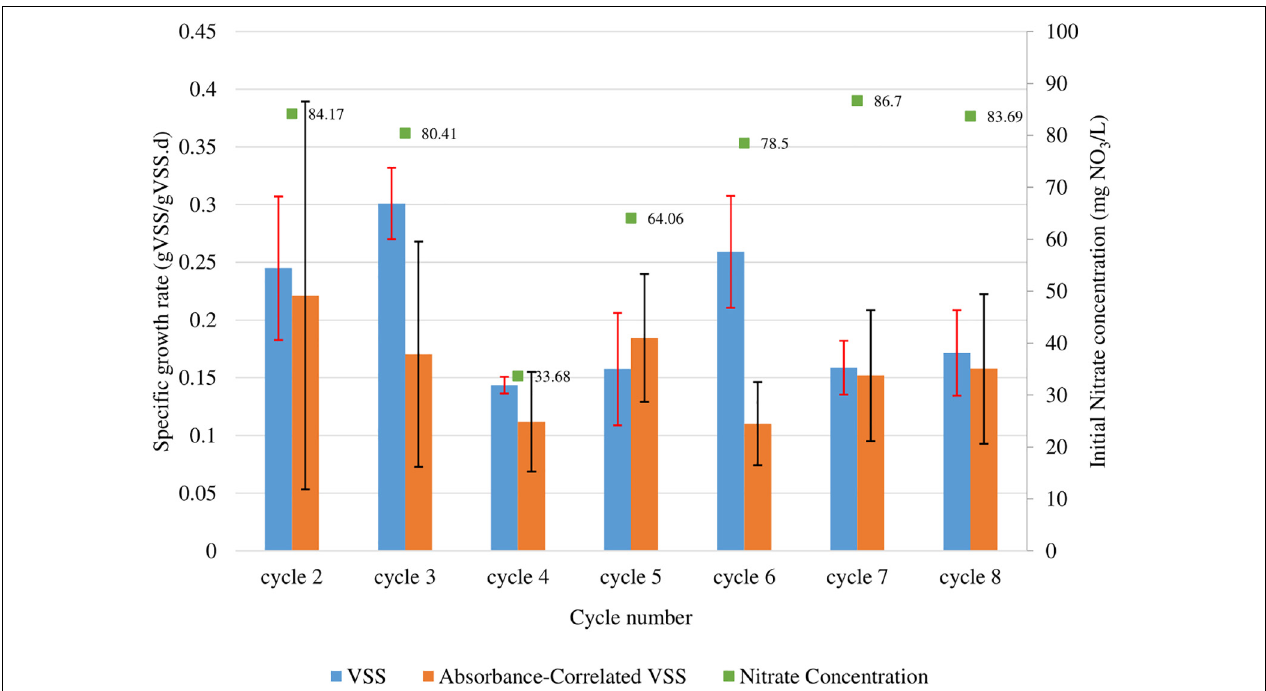
FIGURE 2 | Observed maximum growth rates of N. gaditana calculated from fitted growth curves for each batch cycle run. These growth rates were calculated from the change of mass (gVSS/L) (blue) , as well as by absorbance using the correlations obtained for OD 550 (orange) . Red and black error bars correspond to the 95% confidence interval of the calculation for the VSS and absorbance correlated VSS biomass quantification methods respectively. The starting NO 3 concentrations for each batch are also shown above each bar (green) .